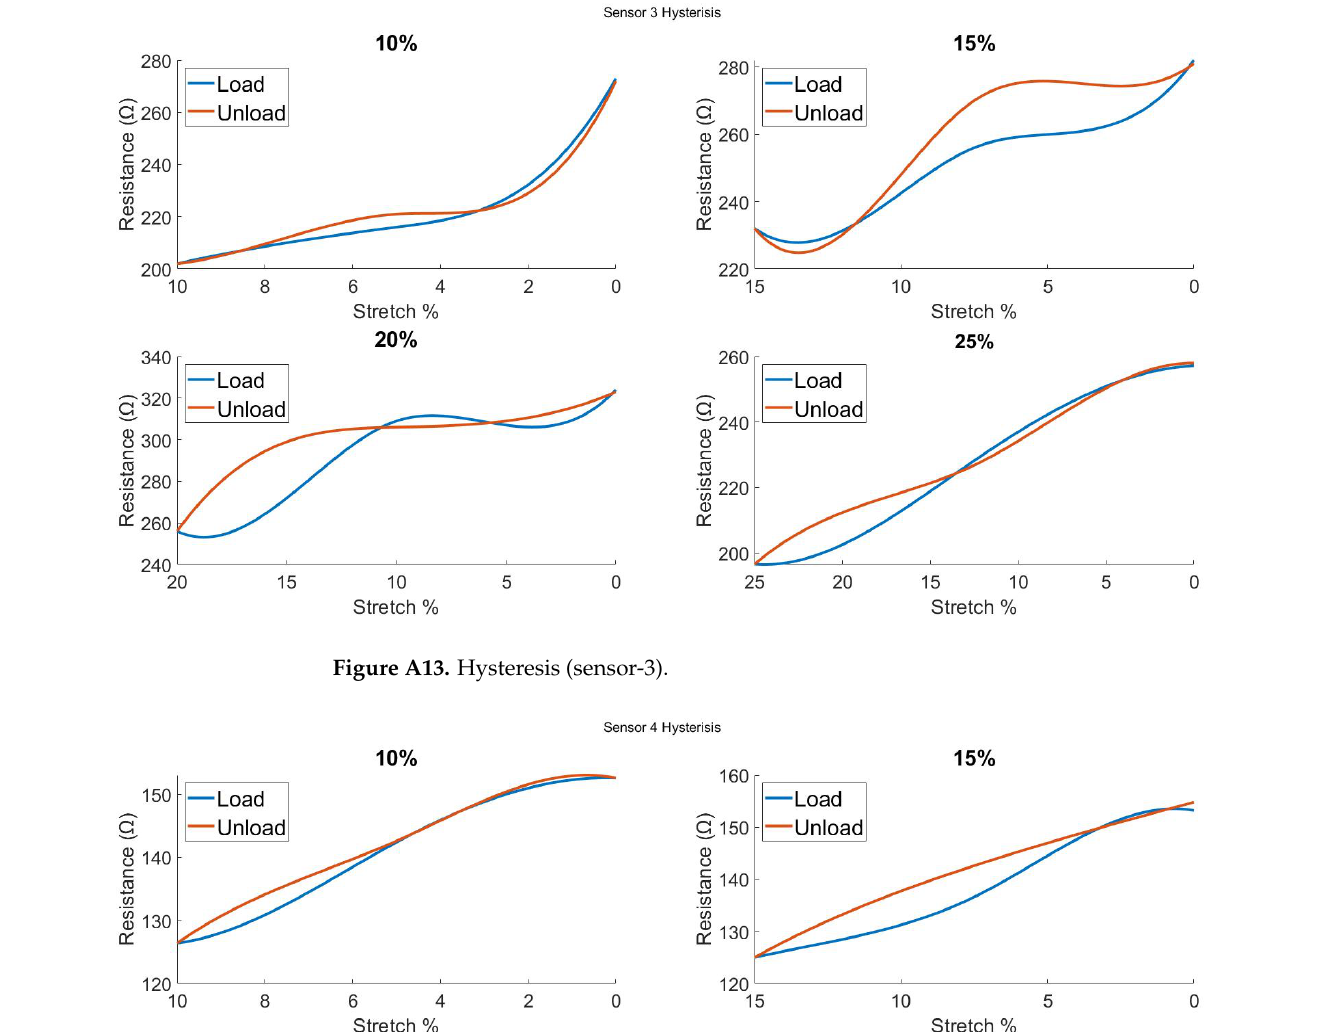
Figure A13. Hysteresis (sensor-3).